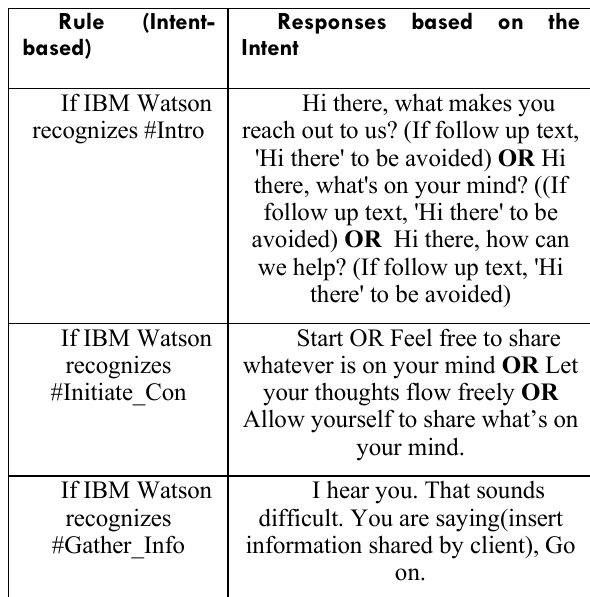
Table 15. Dialog Flows configured for the